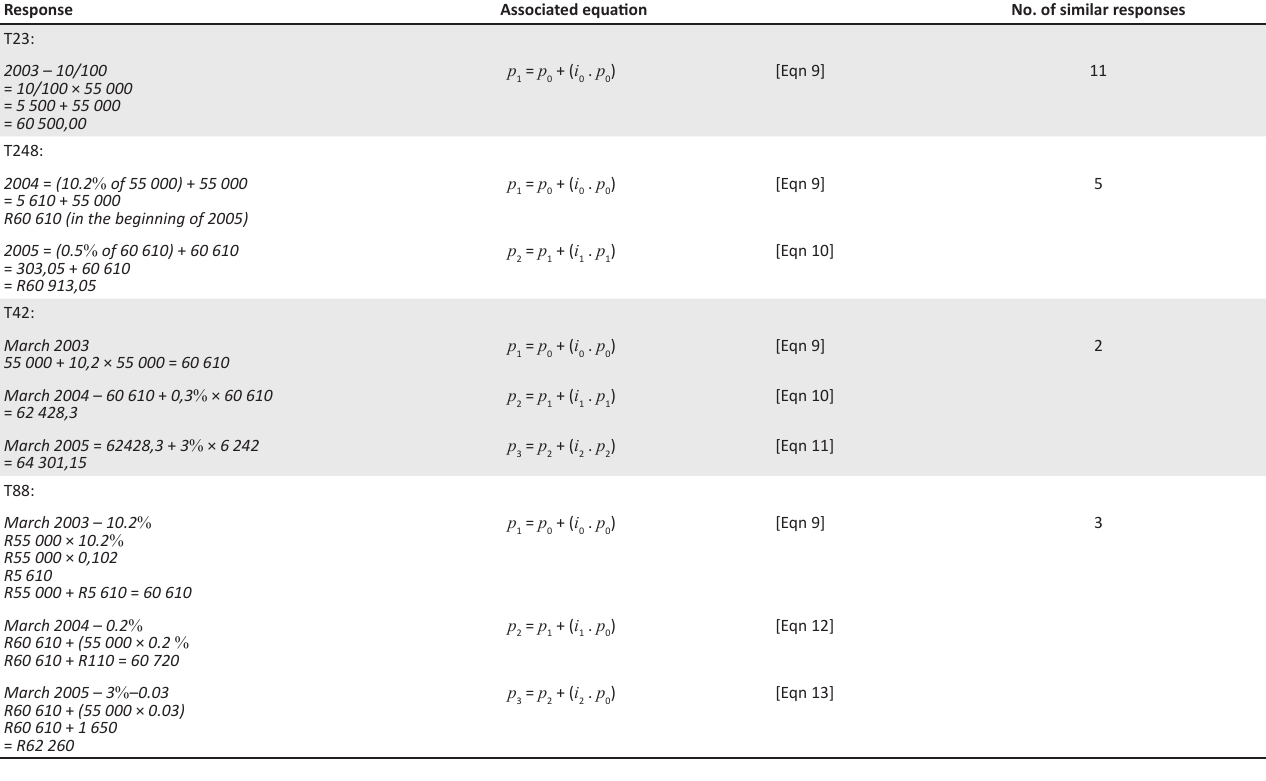
TABLE 4: Responses that used the inflation rate i 0 .